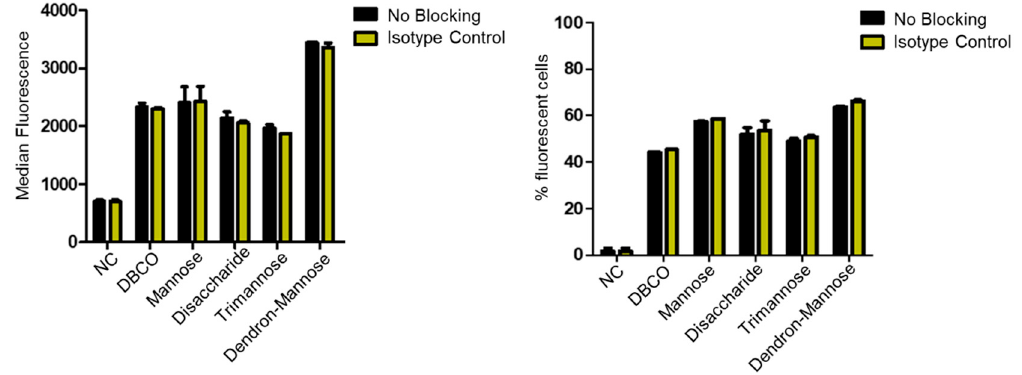
Figure 4. Flow cytometry analysis of hDCs which were treated with an IgG isotype control prior to incubation with differently modified HES nanocapsules. The experiments were performed in duplicates using ANOVA for data evaluation with a p -value = not significant.